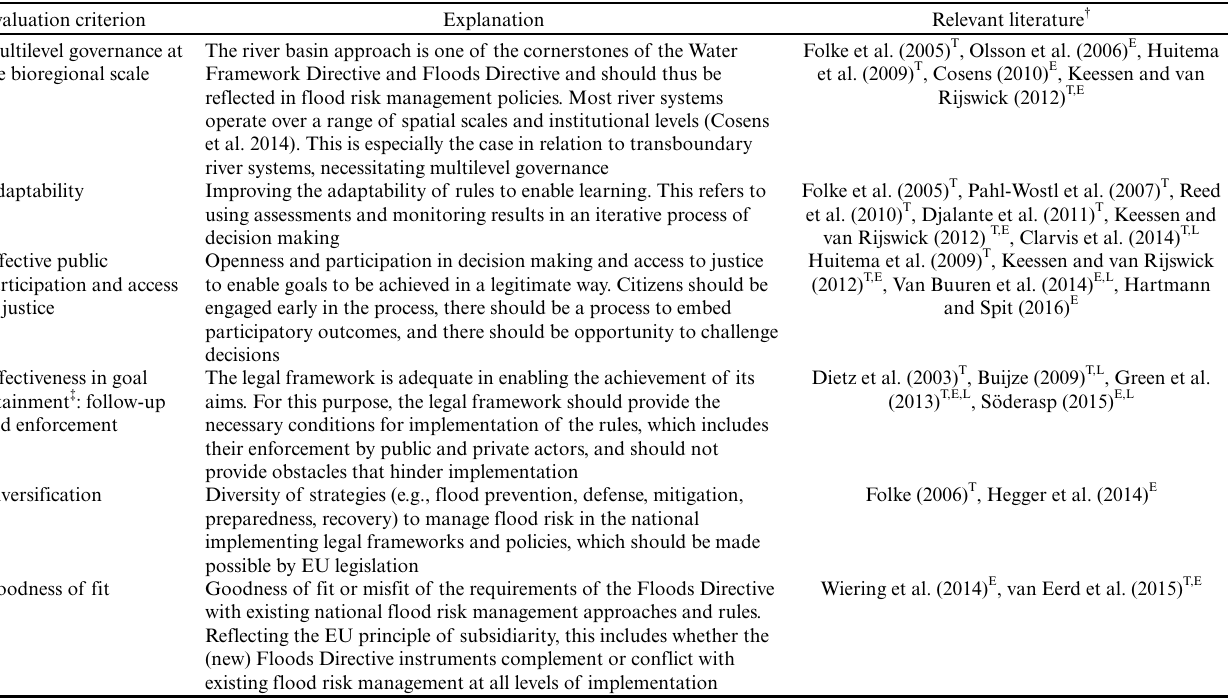
Table 1. Evaluation criteria to assess the resilience of European Union and national flood risk management